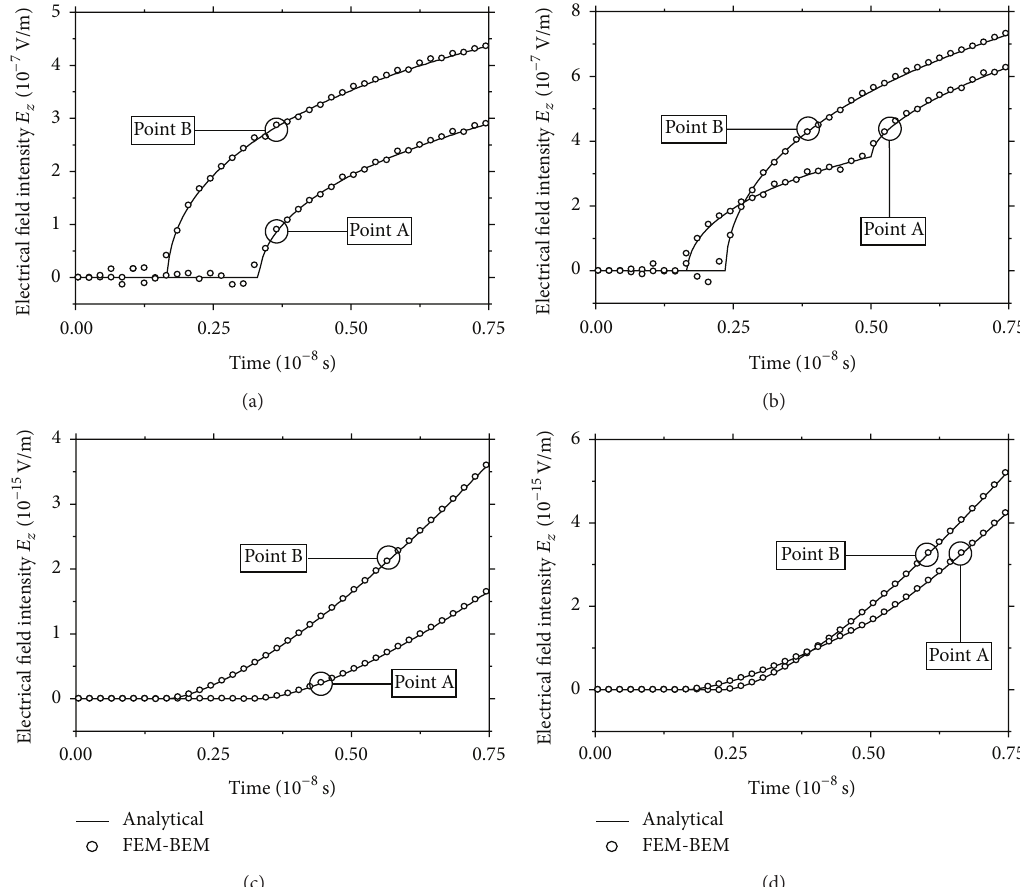
Figure 4: Time history results for the electric field intensity at points A and B considering 𝐼(𝑡) = 𝑡 and (a) case 1 and (b) case 2; 𝐼(𝑡) = 𝑡 2 and (c) case 1 and (d) case